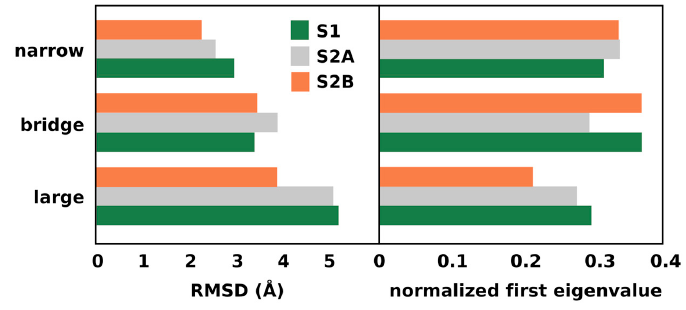
Figure 4. Total root mean square deviation and normalized first eigenvalue of the water positions in the previously identified water channels.